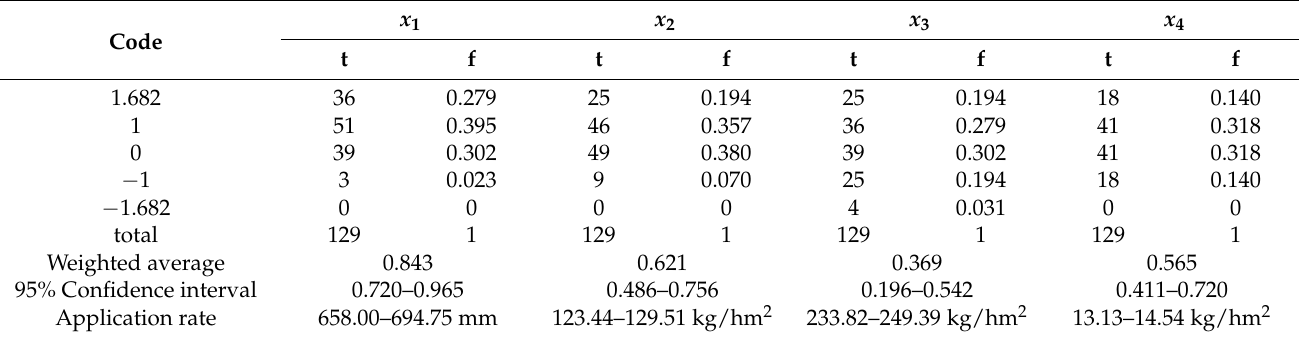
Table 5. Optimization scheme and frequency of target output.